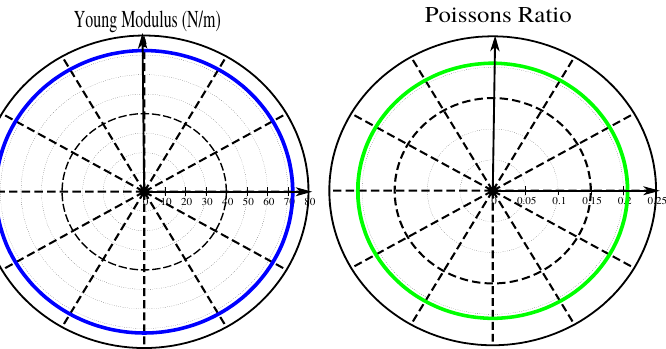
Figure 2. Orientation dependence on the in-plane Poisson’s ratio ( ν 2 D ) and Young’s modulus (Y 2 D ) of Al 2 SSe